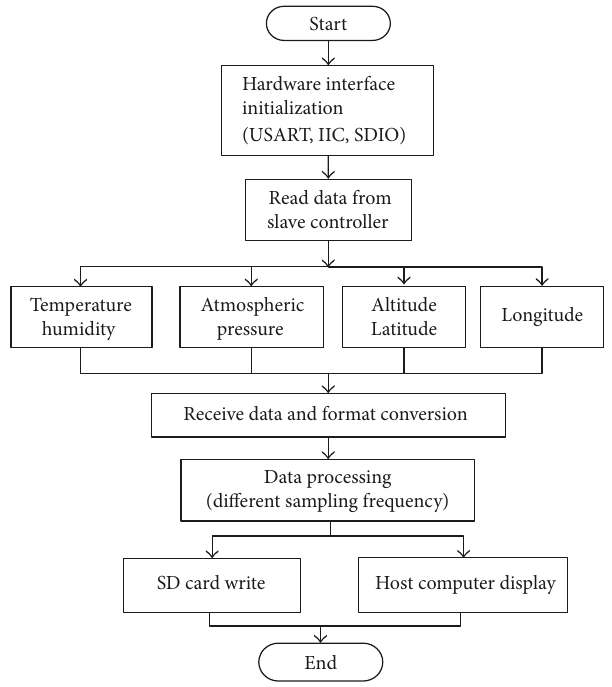
Figure 14: Program design fl ow